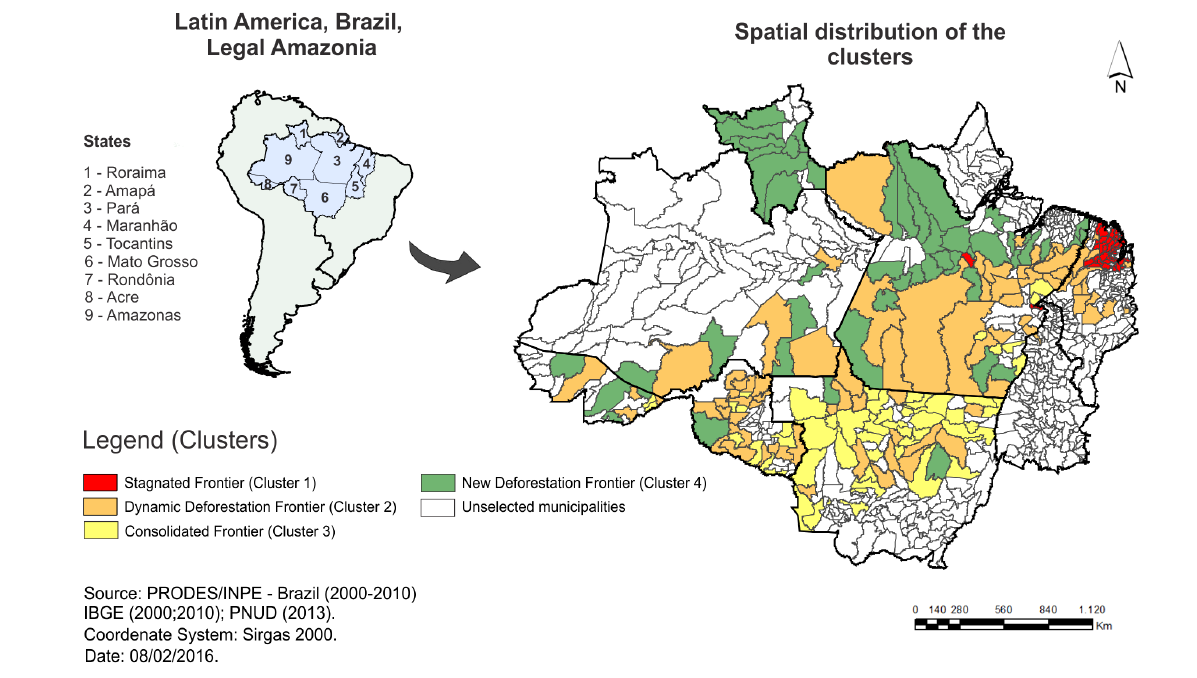
Fig. 3. Spatial distribution and main characteristics of the frontiers in the arc of deforestation, Legal Amazonia,